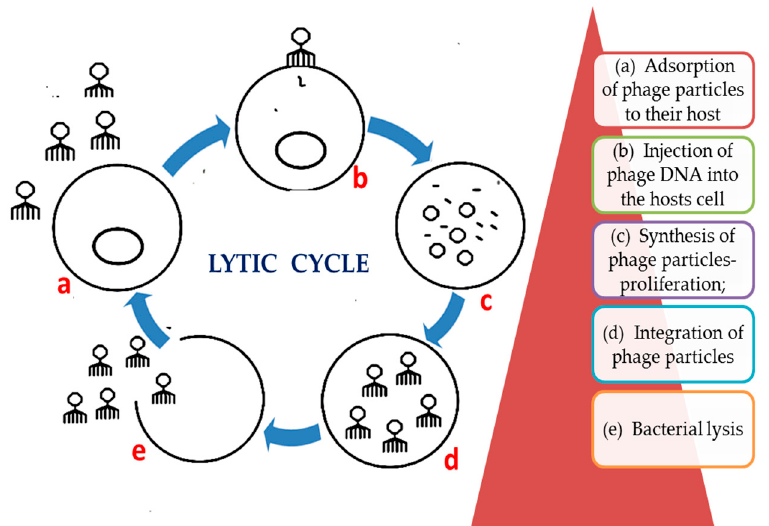
Figure 2. The lytic cycle of bacteriophages.